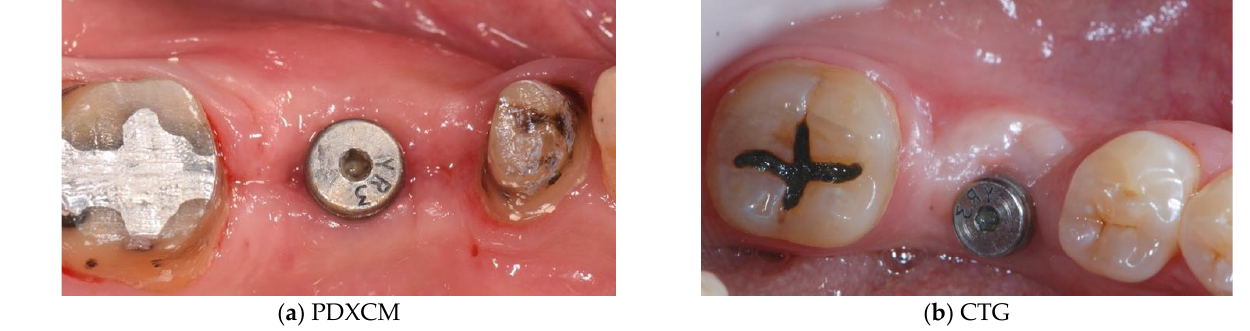
Figure 6. ( a , b ) Clinical situation after 3 months. Table 6 Advantages/disadvantages of XCM, PDXCM, vs. CTG.